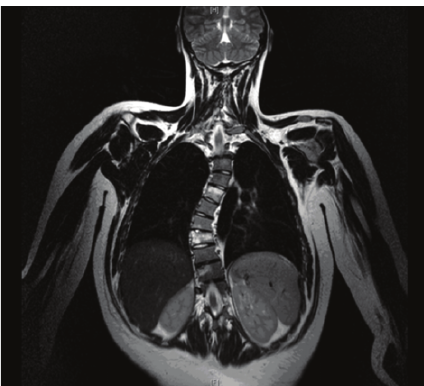
Figure 1: Coronal Thoracic Spine MRI image, T2W. Abnormal high signal in T5 and T8 vertebral bodies with right atypical thoracic